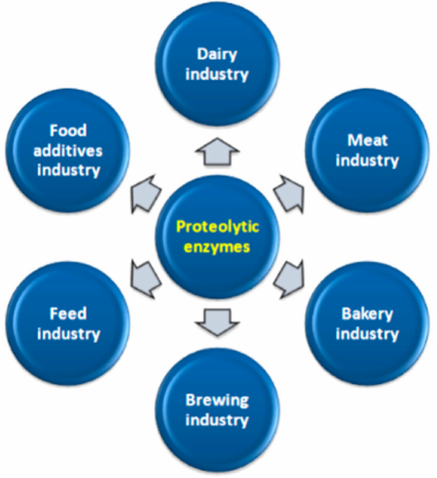
Figure 3. Examples of industrial use of proteolytic